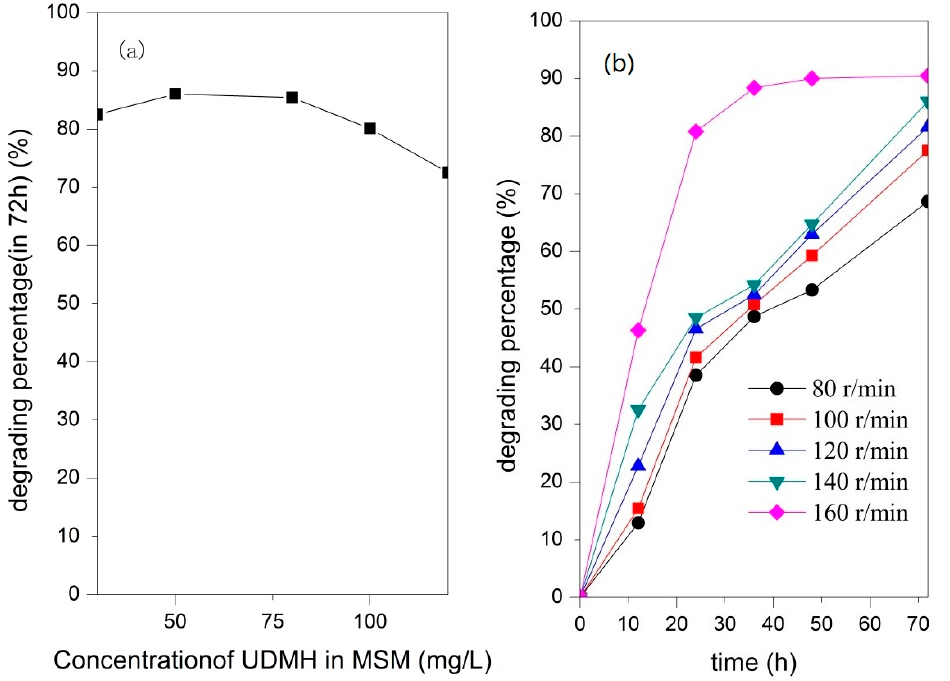
Figure 7. The influencing factors on UDMH degradation for M12 in liquid MSM: ( a ) the concentration of UDMH; ( b ) the shaking speed.